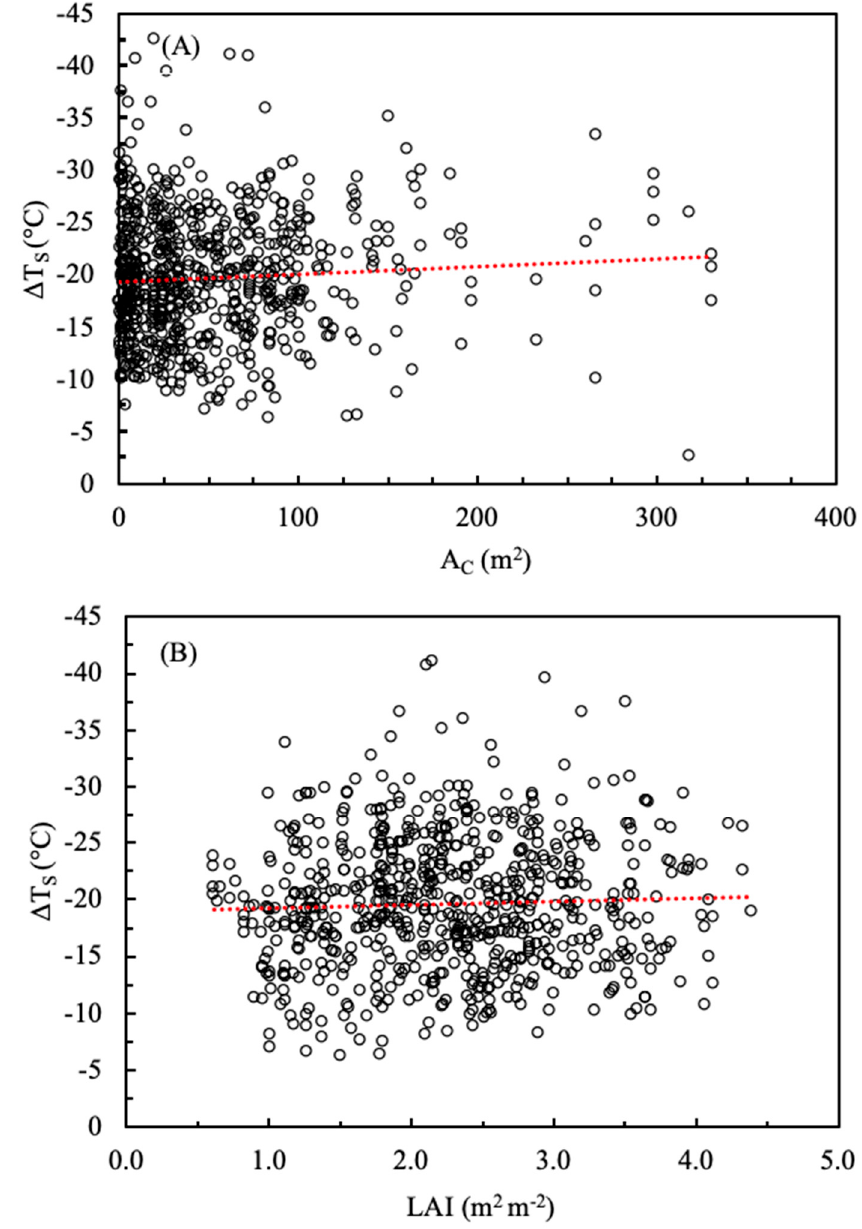
Figure 3. Relationships between tree crown characteristics and surface cooling, calculated as differential between the surface temperature in the sun and shade of a given surface type ( Δ T S ). Panel ( A ): vertical crown projected area (A C ) and surface temperature differential ( Δ T S ); panel ( B ): Leaf Area Index (LAI) and surface temperature differential ( Δ T S ). Data are shown for 471 individual trees from 13 species growing in urban environments across greater Sydney, Australia. Dotted lines show linear fits.